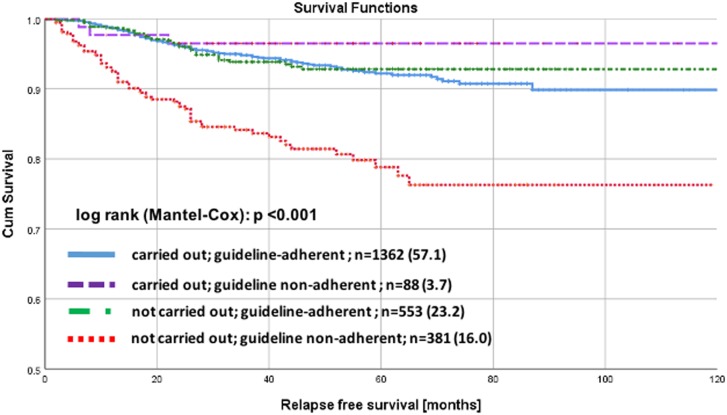
Recurrence free survival for early breast cancer patients aged ≥ 70 years.Kaplan-Meier curves of recurrence free survival for early breast cancer patients aged 70 years and older, stratified by guideline-adherent radiotherapy.